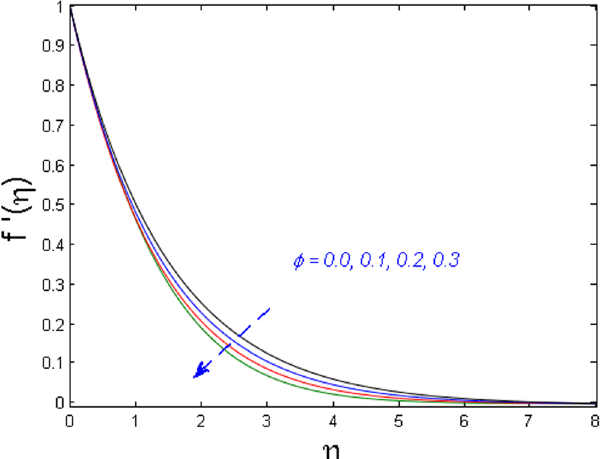
Figure 2. Effect of φ on f ′ ( η ).